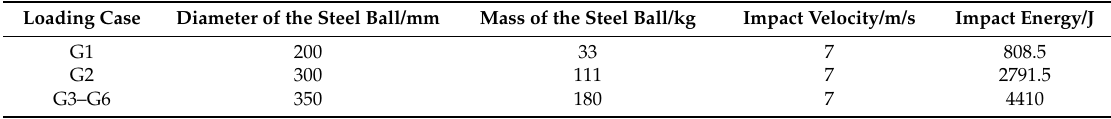
Table 2. Test loading